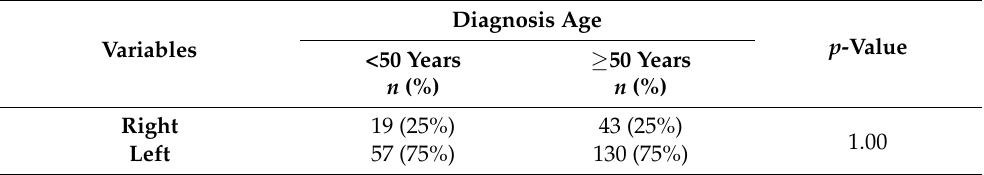
Table 4. Clinicopathological comparison between early onset and late onset